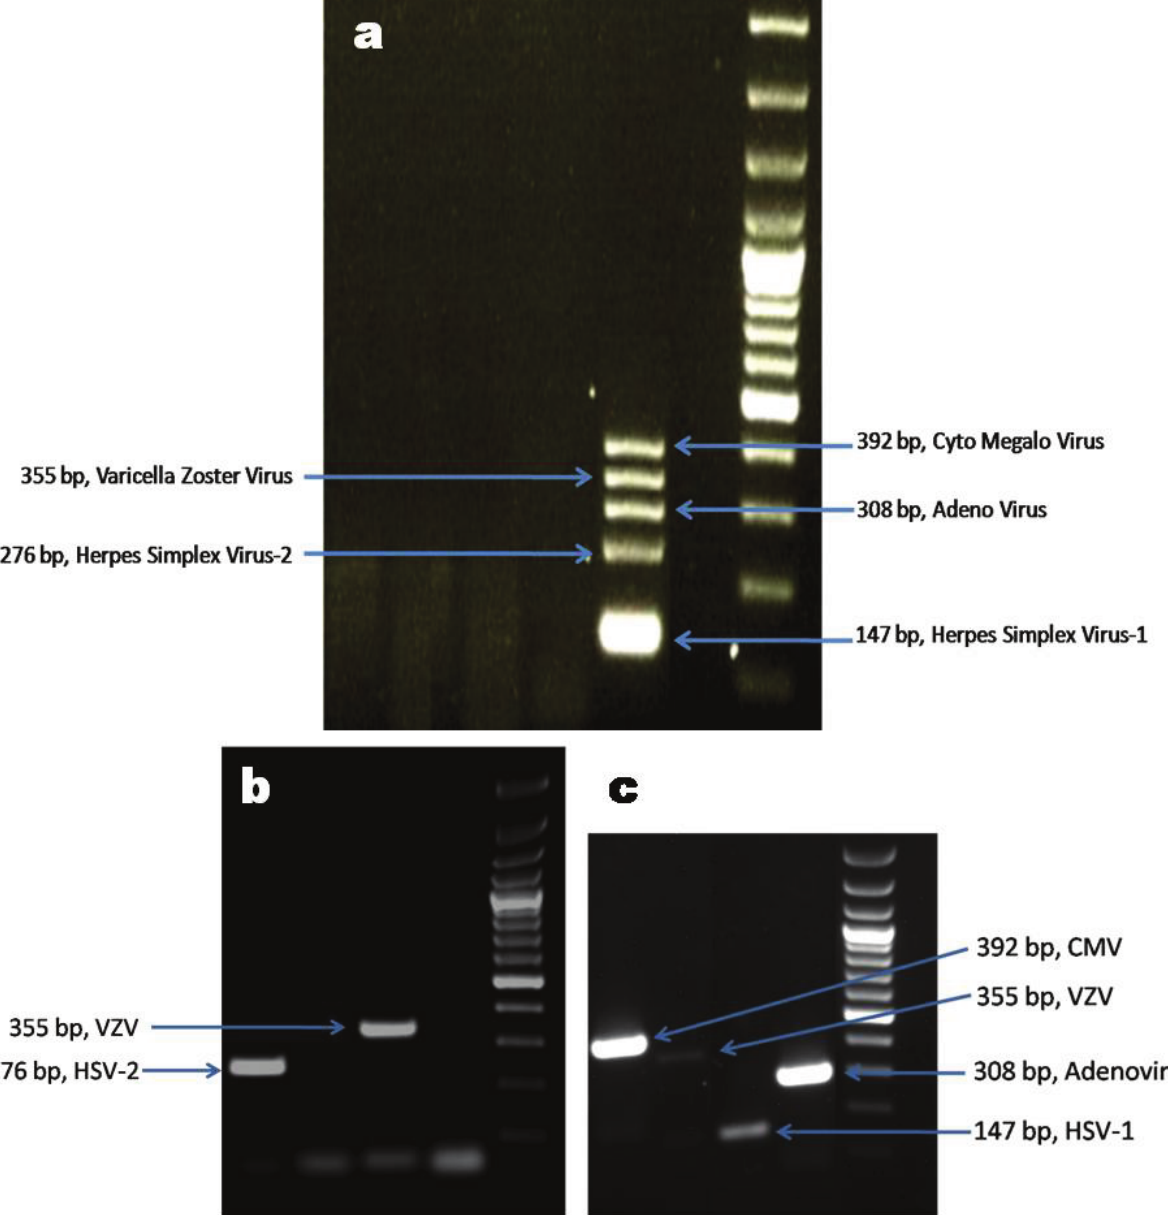
Figure 1. Gel images of positive controls and positive test samples by multiplex PCR. (a) Multiplex PCR simultaneously detecting all five viruses, (b) Ocular specimens positive for HSV-2 and VZV by multiplex PCR, and (c) Ocular specimens positive for CMV, VZV, HSV-1, and Adenovirus by multiplex